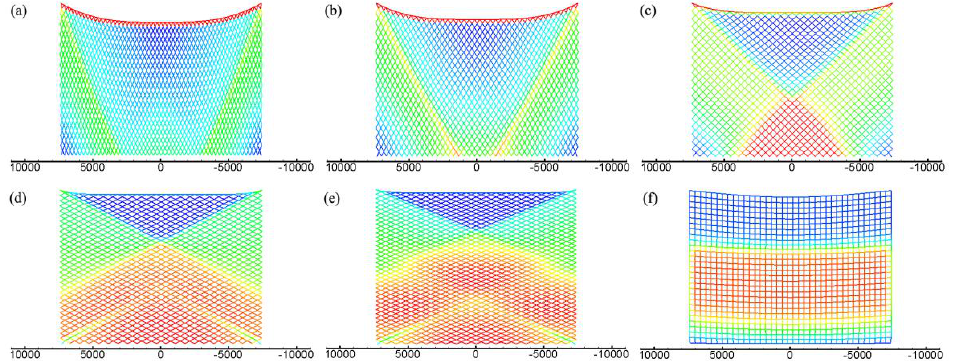
Figure 14. Distribution of the tension force on the trash-blocking nets for different hanging ratios: (a) R h =0.3535; (b) R h =0.4730; (c) R h =0.7070; (d) R h =0.8826; (e) R h =0.9191; and (f) Square mesh. ( a ) R h = 0.3535; ( b ) R h = 0.4730; ( c ) R h = 0.7070; ( d ) R h = 0.8826; ( e ) R h = 0.9191; and ( f ) Square